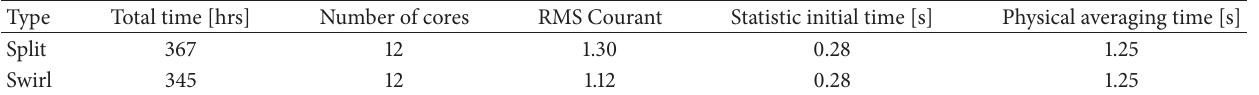
Table 3: Summary of the CFD